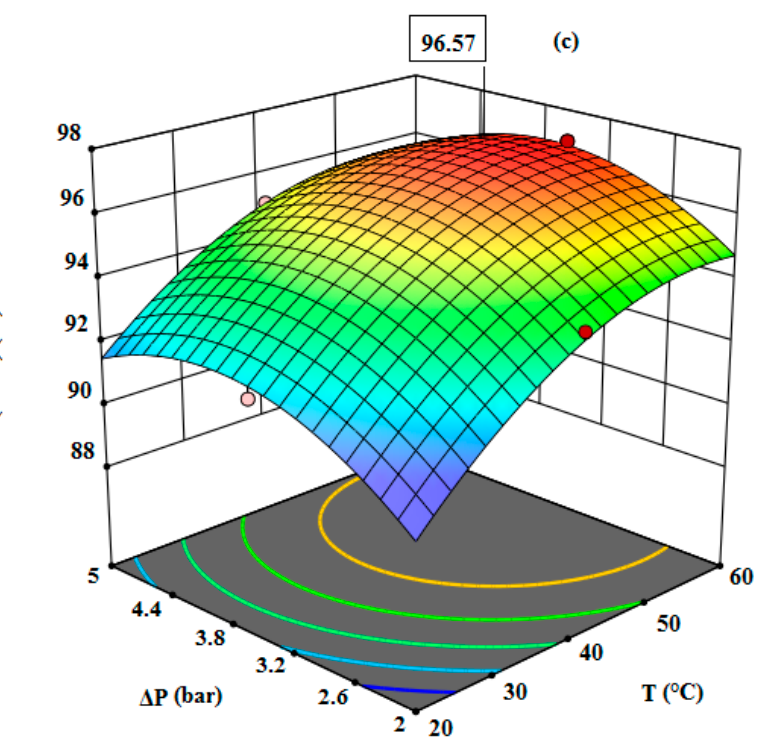
Figure 6. The response surface plots showing the effects of variables on COD removal: The interac- tion of initial oil concentration and temperature ( a ), the interaction of initial oil concentration and transmembrane pressure ( b ), the interaction of temperature and transmembrane pressure ( c ).